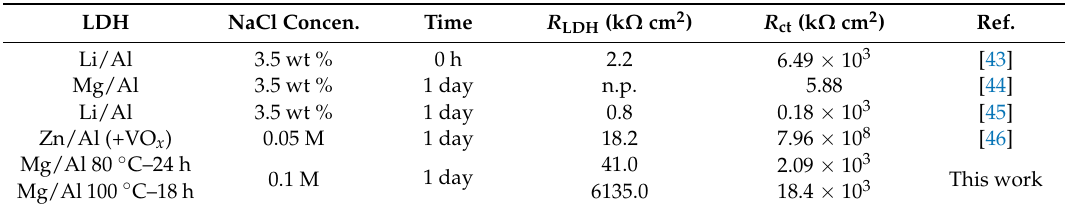
Table 5. Comparison with literature data referring to LDH conversion layers/coatings on aluminum alloys (n.p.: not